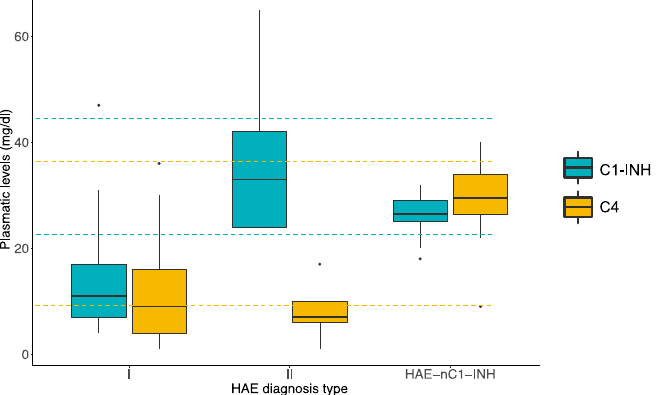
Figure 1. Plasmatic concentration of C1-INH and C4 among the different diagnosis type of HAE with reference values for each protein. The dotted lines indicate the upper and lower reference values for the corresponding proteins (indicated by colors) and black dots represents outliers determinations of plasmatic protein concentration.